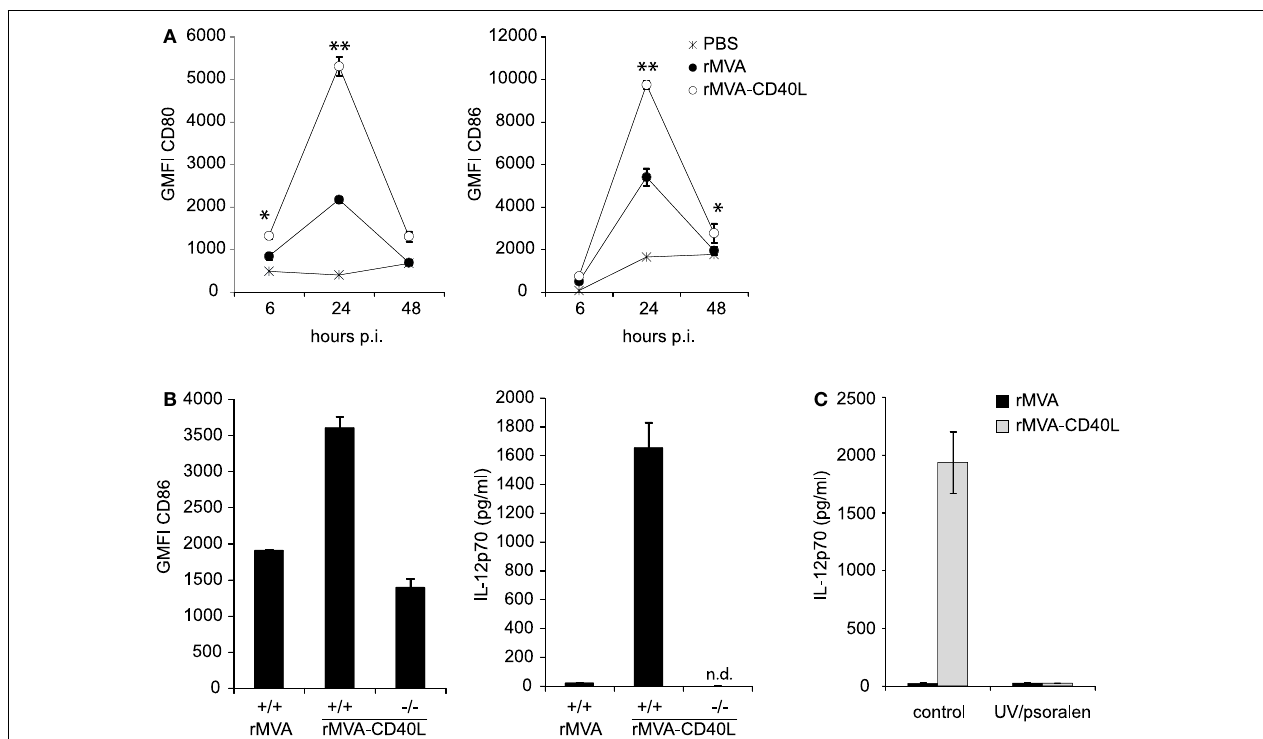
CD40L, we immunized CD40 + / + C57BL/6 mice with rMVA or rMVA-CD40L and CD40 − / − mice with rMVA-CD40L. Serum concentration of IL-12p70 was determined 6h after injection and CD86 expression was analyzed on splenic DCs after 24h. (C) C57BL/6 mice were immunized with active or UV/psoralen-inactivated rMVA and rMVA-CD40L. Serum concentration of IL-12p70 was determined 6h after injection and CD86 expression was analyzed on splenic DCs after 24h. Shown is the mean ± SEM of three to six mice per